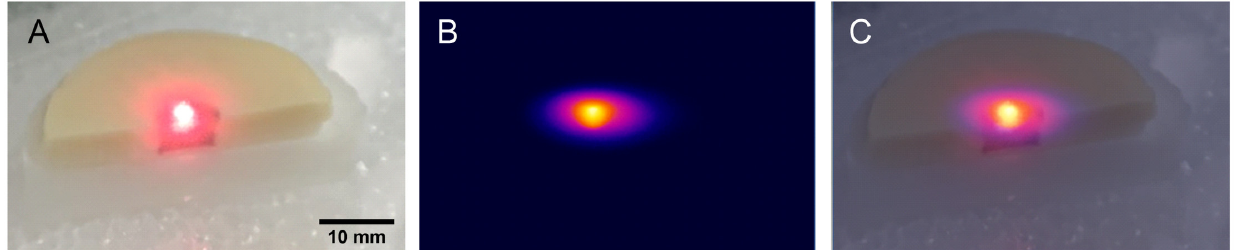
Figure 5. ( A ) Cross-section picture of a skin-like phantom with two different regions that mimic the normal and tumoral tissue treated with AuNTs@780, under laser irradiation, ( B ) thermal contrast image of the skin phantom after 5 min of laser irradiation, ( C ) merged A and B images.